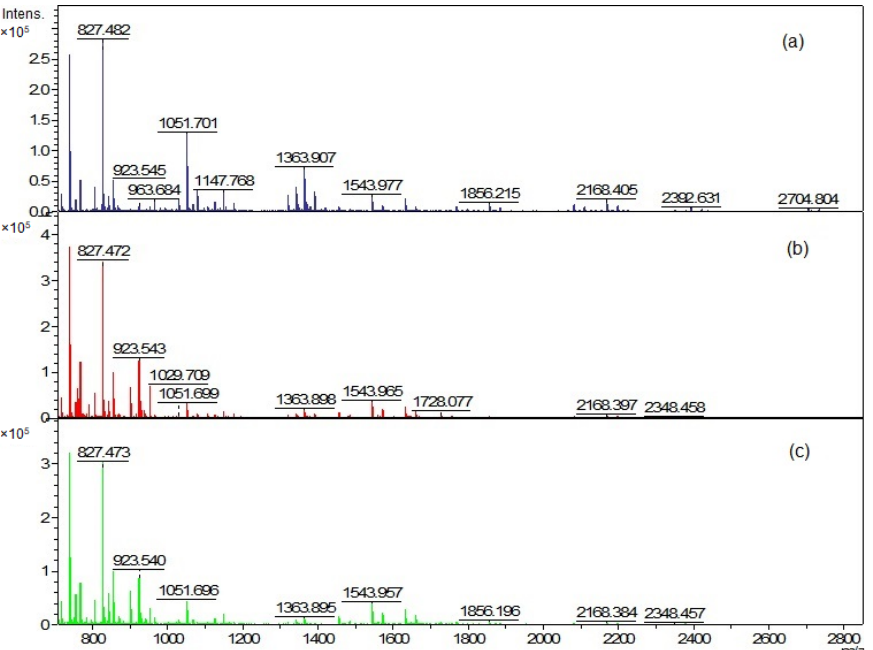
Figure 8. Positive ion MALDI-TOF MS spectra of whole-cell lipid extracts ( a ) C. acnes DSM 1897 type IA1, ( b ) C. acnes DSM 16379 type IB, and ( c ) C. acnes PCM 2334 type II.